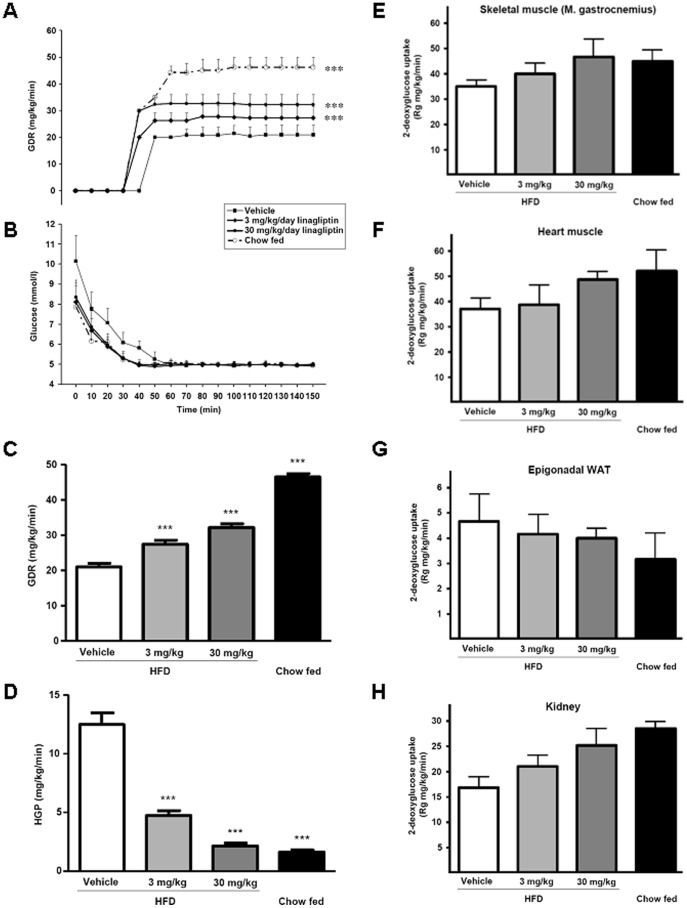
Effect of linagliptin on insulin sensitivity determined by euglycemic–hyperinsulinemic clamps in diet-induced obesity (DIO) mice.C57BL/6 mice were fed a high-fat diet (HFD) or chow diet for 3 months followed by treatment with linagliptin (3 mg/kg/day or 30 mg/kg/day) or placebo. Four weeks after treatment initiation, euglycemic–hyperinsulinemic clamps were performed to measure glucose disposal rate (GDR) (A), dynamic of blood glucose concentrations (B), and GDR and hepatic glucose production (HGP) during the steady-state period of the euglycemic–hyperinsulinemic clamp (C and D). (E–H) Tissue specific uptake of 2-deoxy-d-[1-14C]glucose into gastrocnemius skeletal muscle (E), heart muscle (F), perigonadal white adipose tissue (WAT) (G) and kidney (H). Blood glucose levels were determined every 10 minutes (B-Glucose Analyzer; HemoCue AB, Ängelholm, Sweden). Values are given as mean ± SD. ***P<0.001 compared with DIO vehicle-treated group.